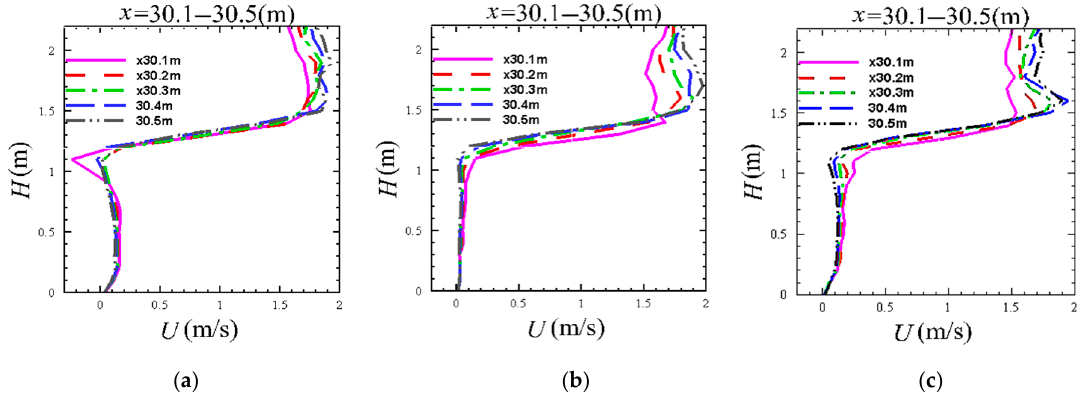
Figure 16. Longitudinal velocity distribution of the flow field inside and directly above the pore structure when the porosity is 0.5, 0.25 and 0.125 and x = 30.1–30.5.0 m. ( a ) n w = 0.5; ( b ) n w = 0.25; ( c ) n w = 0.125.